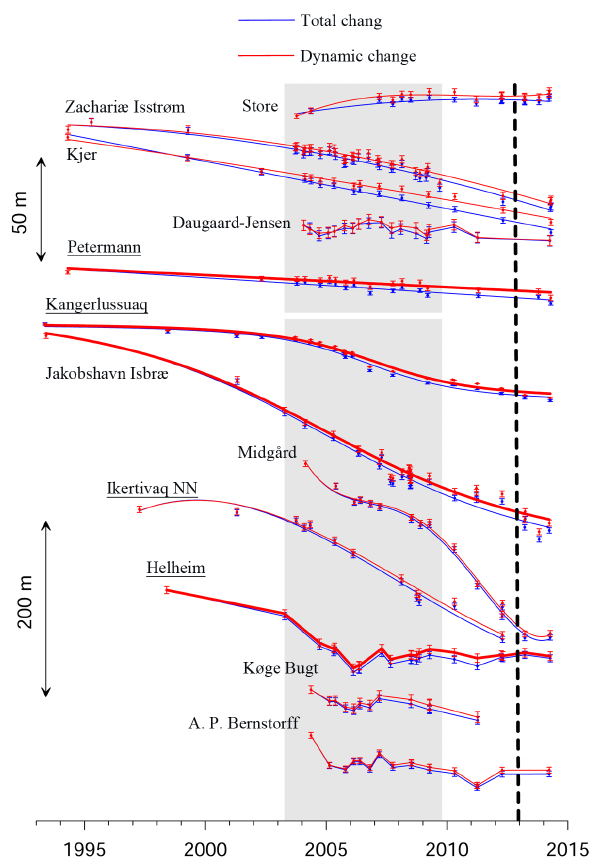
Figure 9. Thickness change time series (blue: total change, red dynamic change) derived from the combined ICESat/ATM/LVIS altimetry record (1993-2014) illustrating different dynamic outlet glacier